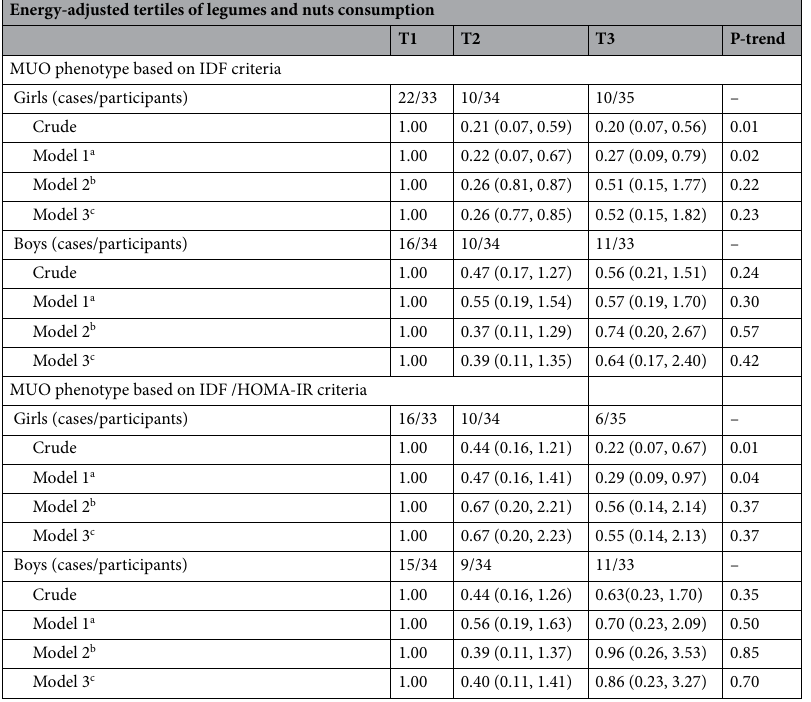
Table 6. Multivariate adjusted odds ratio (OR) and 95% confidence interval (CI) for MUO across energy- adjusted tertiles of legumes and nuts consumption stratified by sex. All values are odds ratios and 95% confidence intervals. a Model 1: adjusted for age, sex and energy intake. b Model 2: additionally adjustments for physical activity and socioeconomic status (parental education, parental job, number of family members, having car in the family, having computer/laptop, having personal room and having trip). c Model 3: additionally adjustment for body mass index